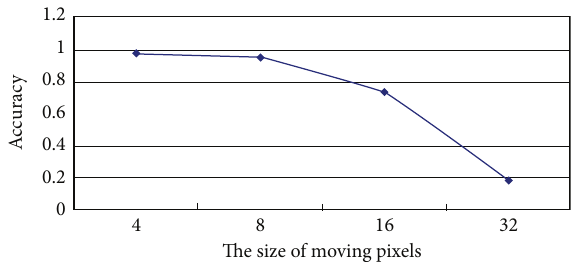
Figure 22: The effect of the shifting steps on detection rate.